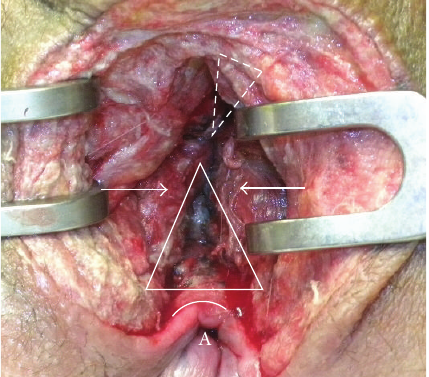
Figure 6: The defect in ventral anal sphincter (white triangle) is demonstrated. The muscular aspects of the anal sphincter are indicated with white arrows. Not clearly shown is the defect in the dorsal urethral sphincter complex (upside down dotted triangle) as it lies deeper. At this stage the anal mucosa (white arch) was already closed. A = anus.